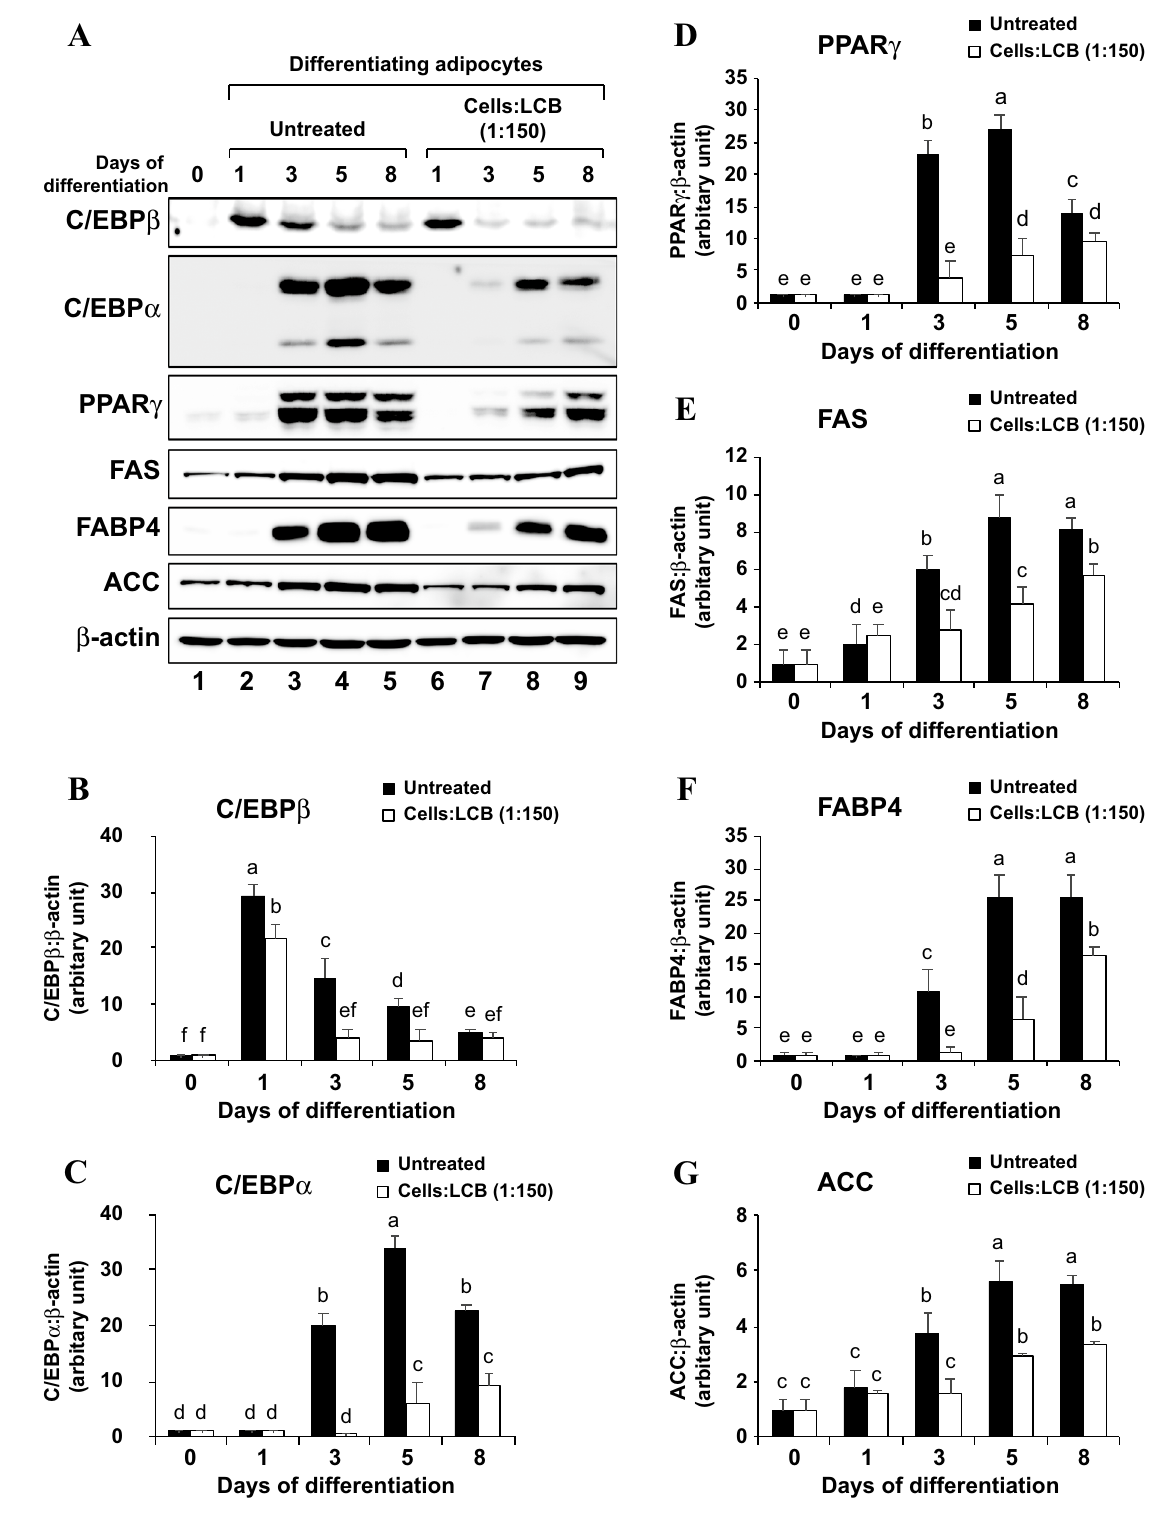
Figure 2. LCB inhibits the expression of key adipogenic transcription factors and enzymes in the differentiating 3T3-L1 adipocytes in a time-dependent manner. (A) shows a representative Western blot data set performed using anti-C/EBPβ, anti-C/EBPα, anti-PPARγ, anti-FAS, anti-FABP4, anti-ACC, and anti-β-actin antibodies. The D/A medium, which initiates the differentiation, was added to the cells without or with LCB (1:150 cells:LCB). Cells were collected on days 0, 1, 3, 5, and 8 for the Western blot analysis. β-actin serves as a loading control. (B–G) show the expression of C/EBPβ, C/EBPα, PPARγ, FAS, FABP4, and ACC proteins, respectively. The protein expression is calculated from the protein:β-actin ratio from each time point and expressed as the relative ratio in respect to the ratio from day 0 of differentiation shown in lane 1 in (A)